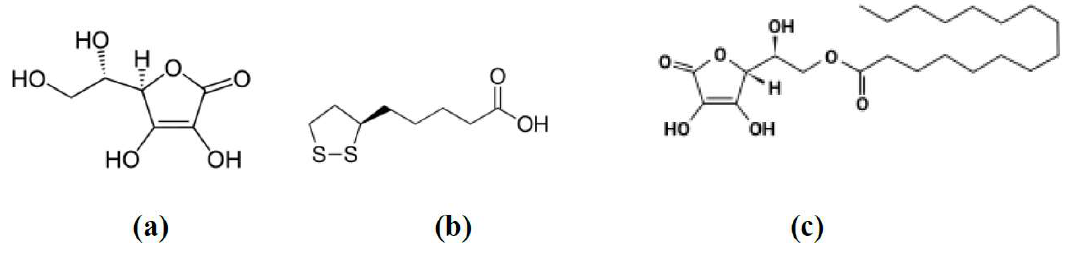
Figure 1. Chemical structures of ascorbic acid ( a ), lipoic acid ( b ) and ascorbyl palmitate ( c ).